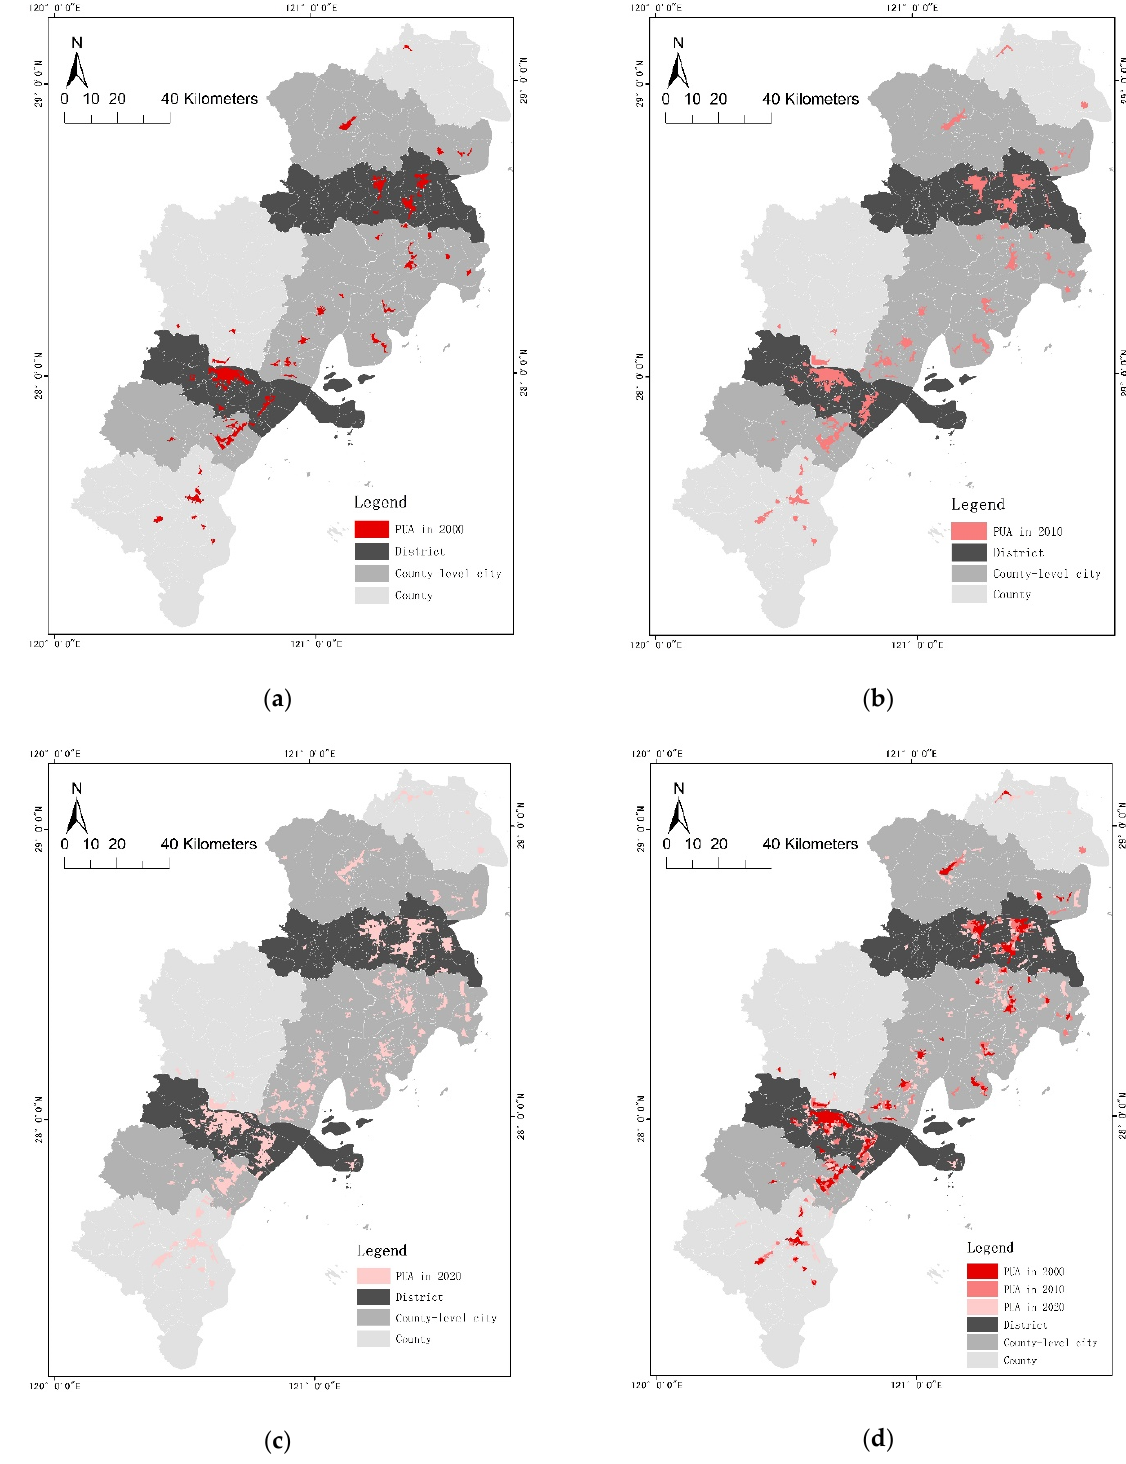
Figure 8. The PUAs of Wen-Tai in ( a ) 2000, ( b ) 2010, ( c ) 2020, and ( d ) three stages overlay.